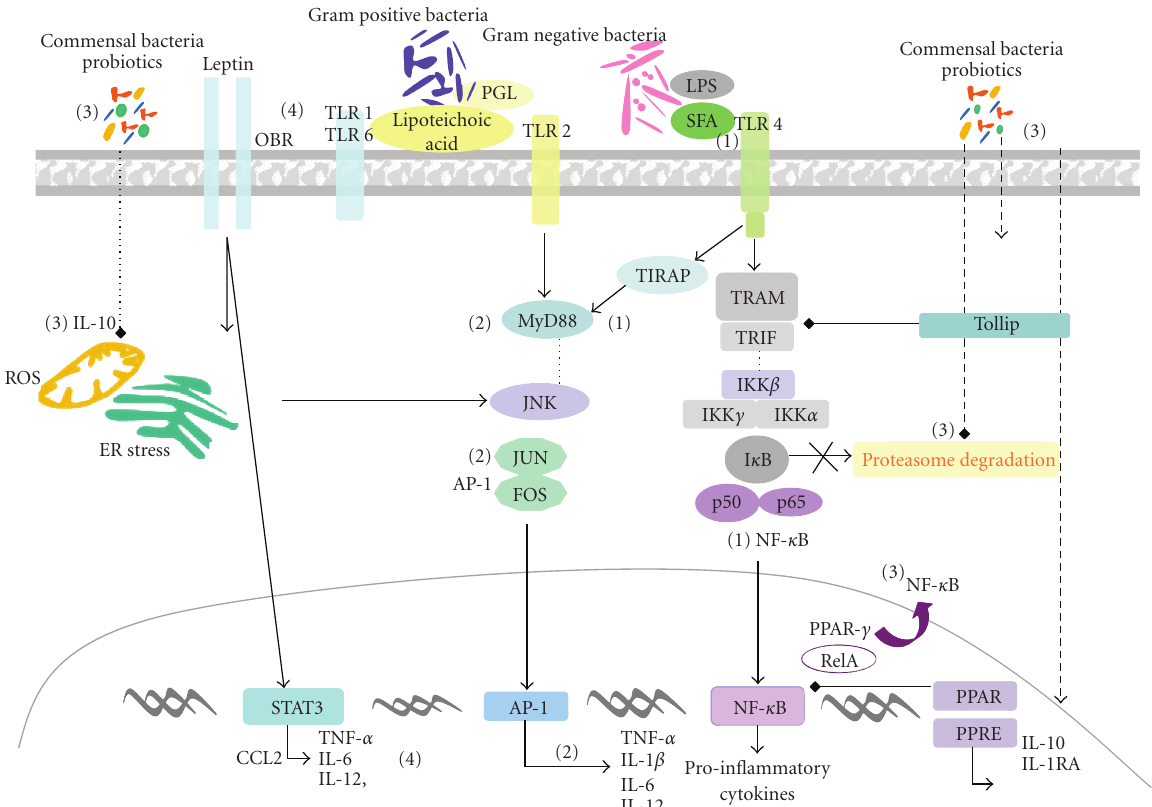
Figure 2: Schematic diagram of signaling pathways triggered by bacterial components, saturated fatty acids, and adipokines in epithelial and innate immune cells leading to either activation or negative regulation of proinflammatory pathways related to obesity and insulin resistance. (1) Lipopolysaccharide (LPS) from Gram-negative bacteria and saturated fatty acids (SFAs) is recognized by toll-like receptor (TLR) 4 activating proinflammatory pathways involving the MyD88 (myeloid di ff erentiation primary-response protein 88)-dependent and -independent pathways that may lead to activation of nuclear factor (NF)- κ B and activator protein-1 (AP-1) with production of pro- inflammatory cytokines. (2) Peptidoglycan (PGL) and lipoteichoic acid from Gram-positive bacteria are recognized by TLR-2 triggering the activation of the MyD88-dependent pathway. (3) Commensal bacteria and some probiotics may suppress activation of NF- κ B cascade by (i) promotion of nuclear export of NF- κ B subunit relA in complex with PPAR- γ ; (ii) inhibition of I κ B ubiquitination and degradation, (iii) induction of anti-inflammatory (IL10) cytokine production. (4) Leptin interacts with its receptors (OBR) activating the signal transducer and activator of transcription (STAT), and induces production of CCL2, proinflammatory cytokines, and reactive oxygen species (ROS) causing endoplasmic reticulum (ER)